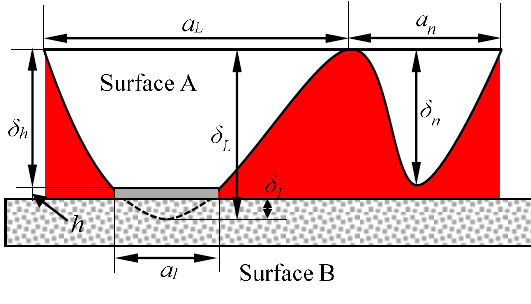
Figure 2. Rough surface contact.